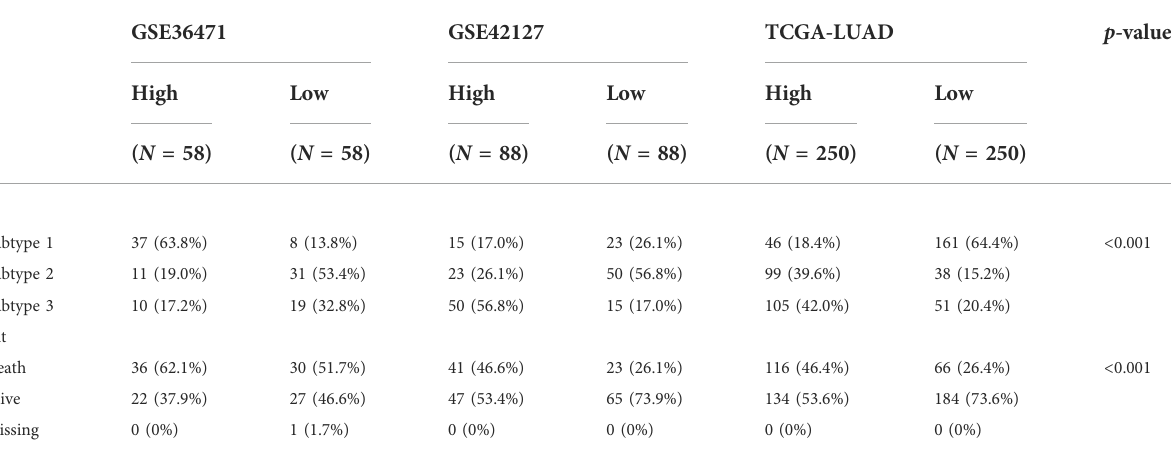
TABLE 1 Clinical baseline features of the LUAD patients in three